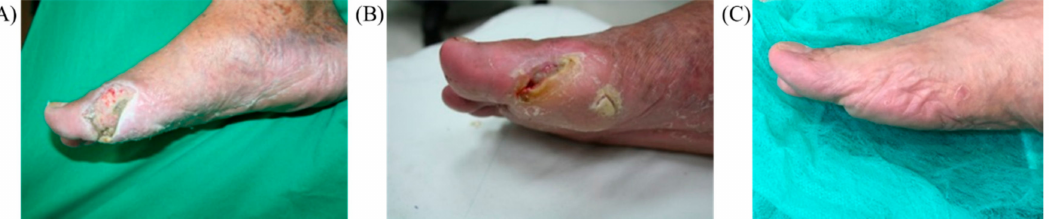
633 nm LLLT in 4 weeks, and ( C ) the final result was observed in 6 months.